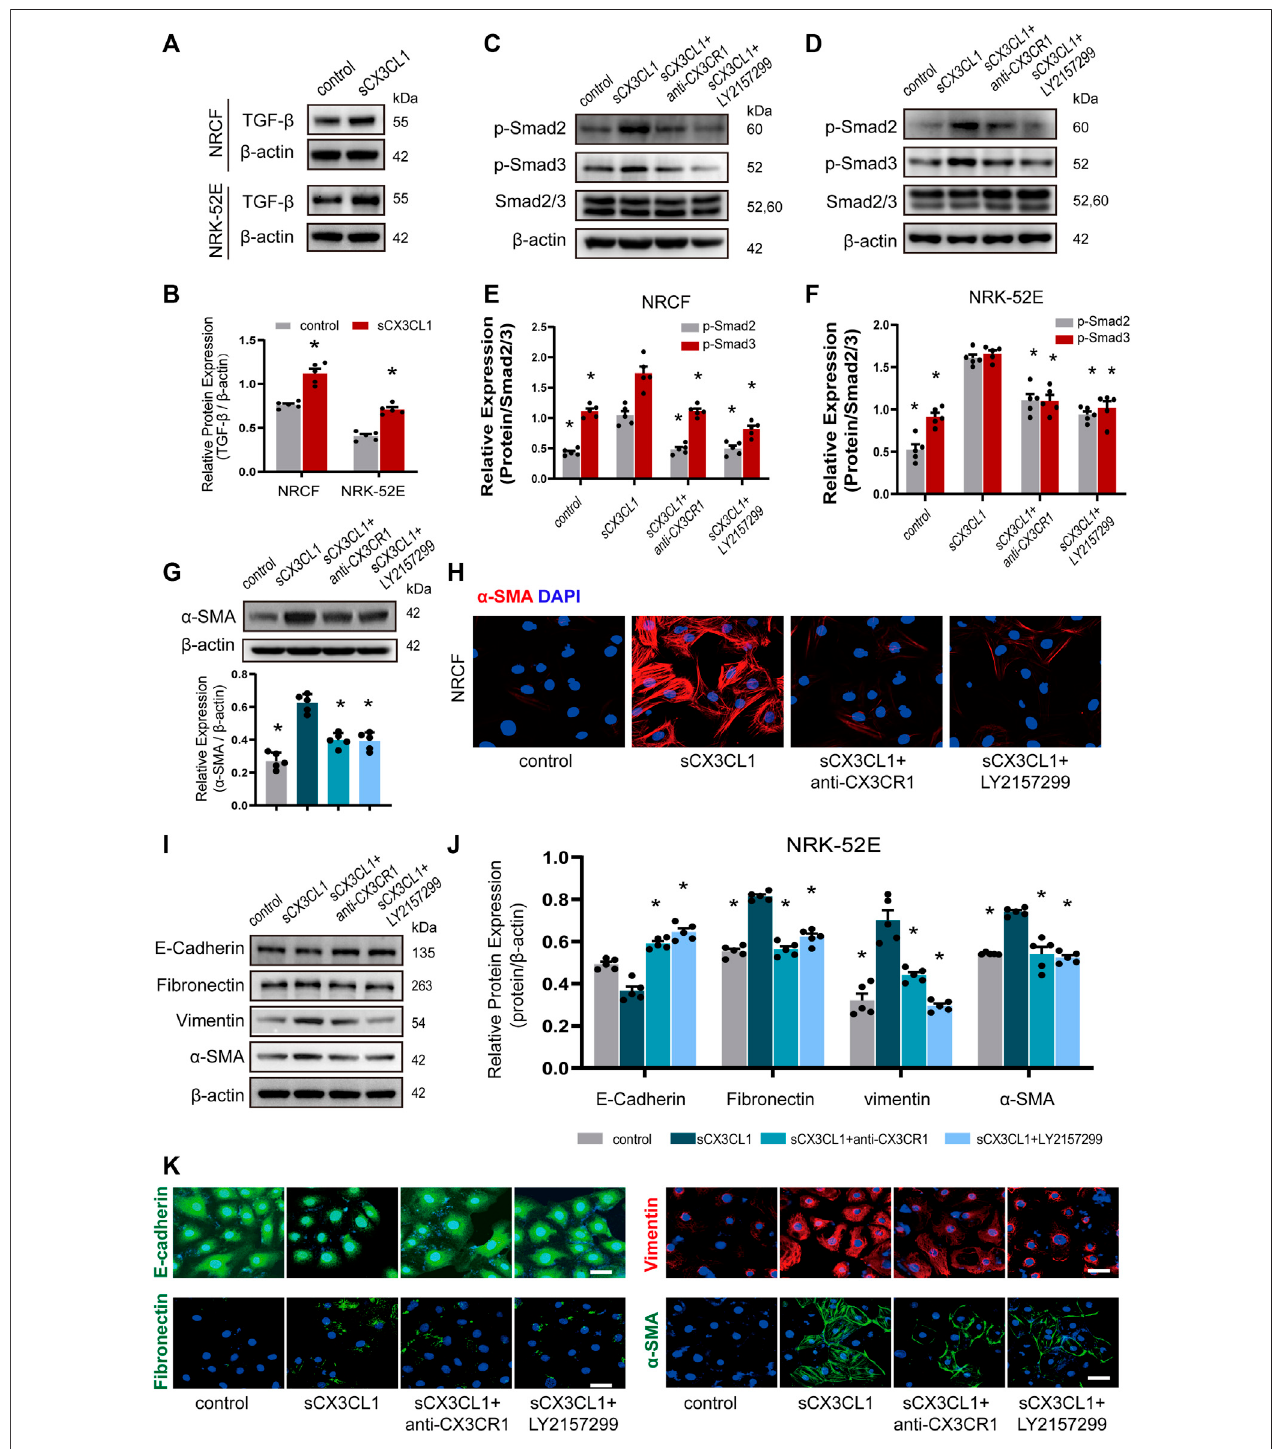
FIGURE 3 | sCX3CL1 promotes cardiac and renal cells transformation in a TGF- β /Smad dependent manner. Representative western blots (A) and semi- quantitative analysis (B) of TGF- β expression in neonatal cardiac fi broblasts (NRCF) and a renal tubular epithelial cell line (NRK-52E) in response to sCX3CL1 stimulation for 24 h. Western blotting (C) and (D) and semi-quantitative analysis (E) and (F) of phosphorylation of Smad2 and Samd3 in NRCF and NRK-52E cells after exposure to sCX3CL1 stimulation alone or with co-treatment by either a CX3CR1 neutralizing antibody or a TGF- β /Smad inhibitor (LY2157299). (G) Marked upregulation of α -SMA protein detected by Western blotting in NRCF after stimulation with sCX3CL1 for 24 h. (H) Transformation to myo fi broblasts assessed by α -SMA (red) staining in NRCF treated with sCX3CL1 or sCX3CL1+CX3CR1 neutralizing antibody or sCX3CL1+LY2157299. Scale bar = 30 μ m.